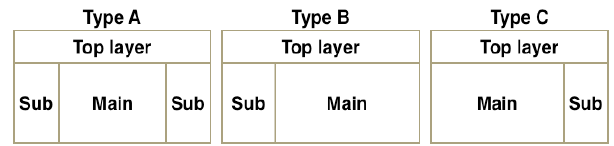
Figure 3. Layout types